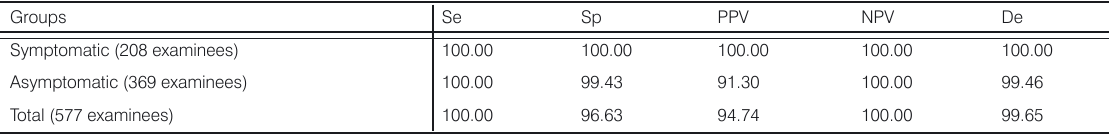
Table 3. Statistical parameters of diagnostic efficiency of the EIA.